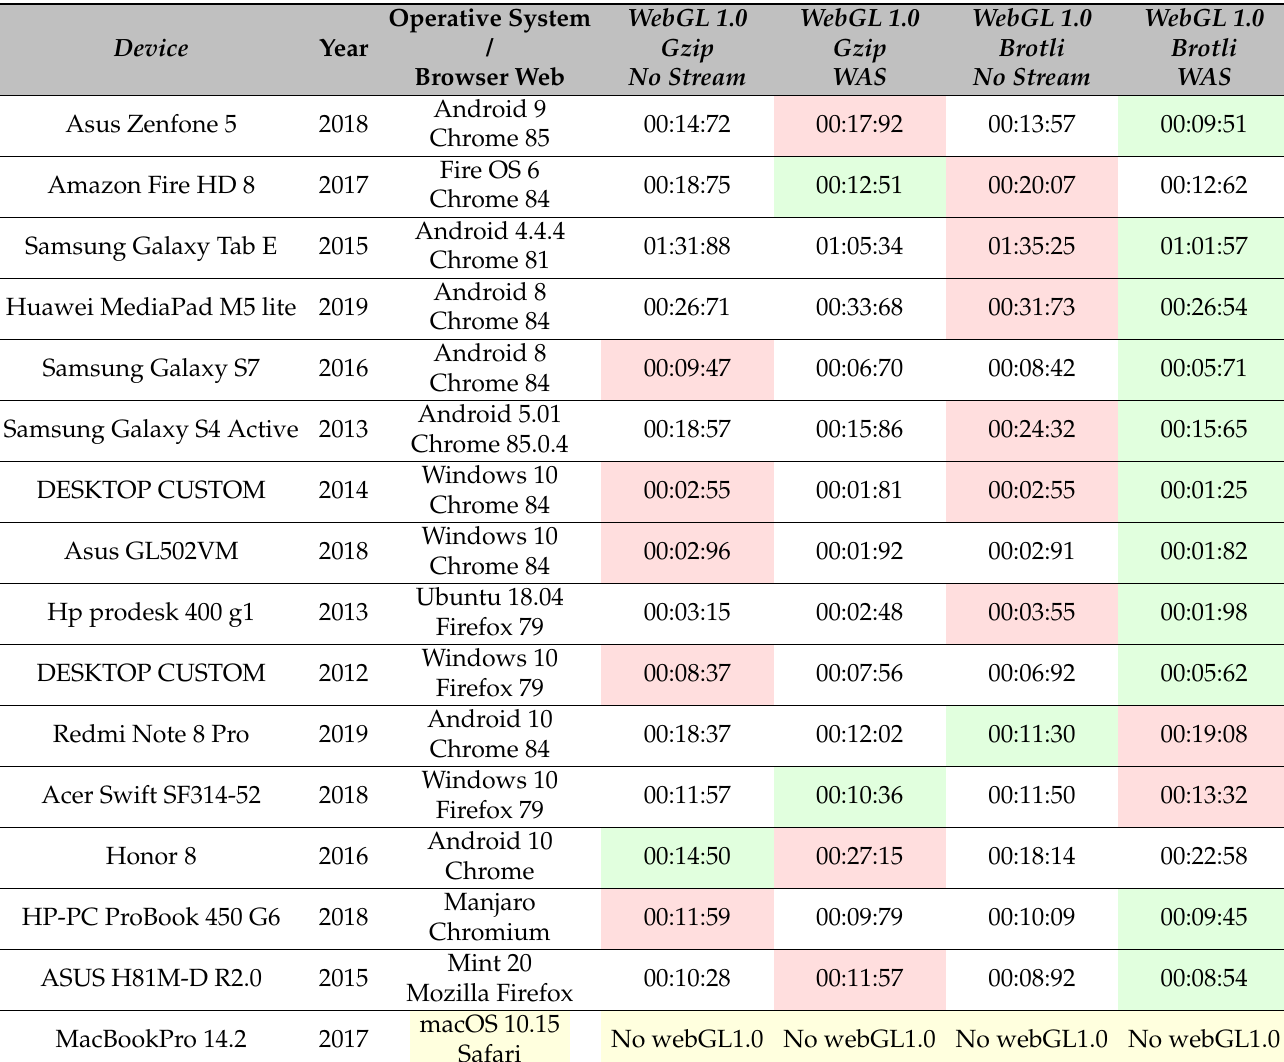
Table 2. WebGL2.0